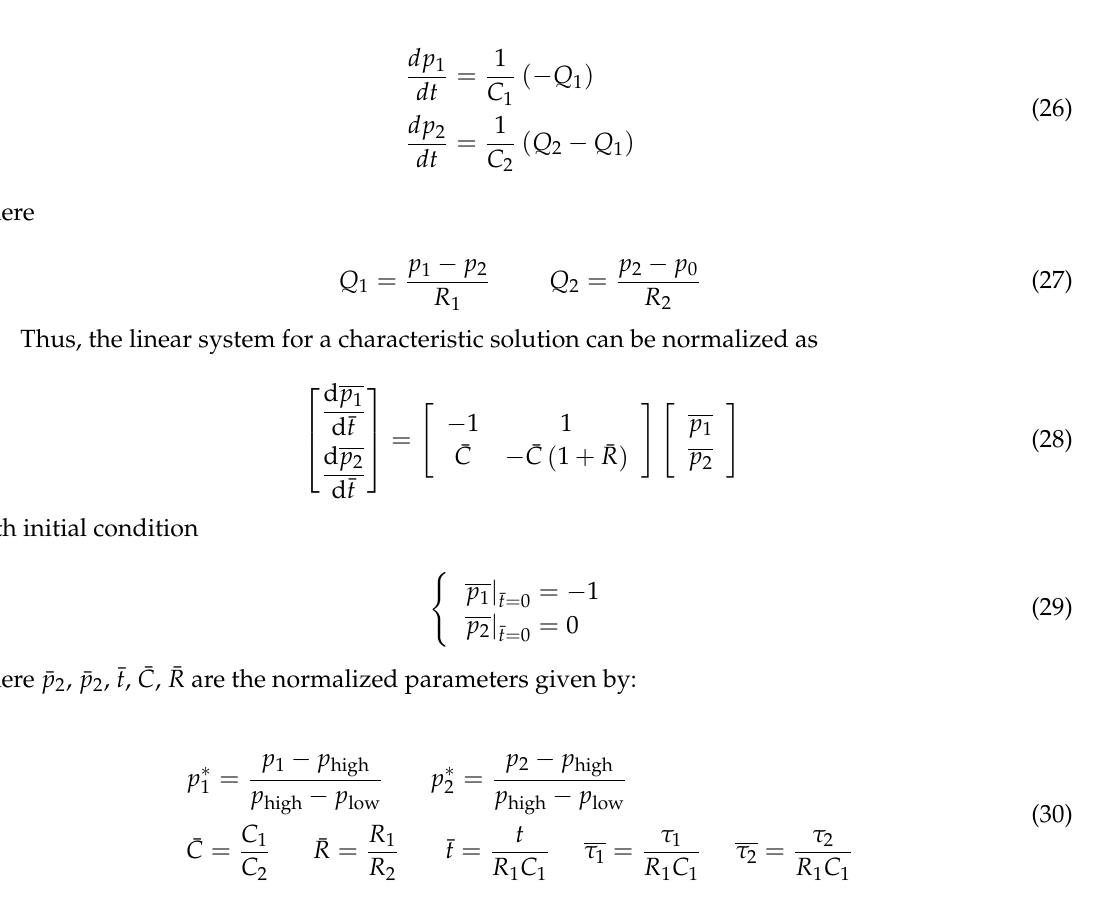
Figure 22. ( a ) The kinematics of single-DC pressurization problem; ( b ) Corresponding hydraulic